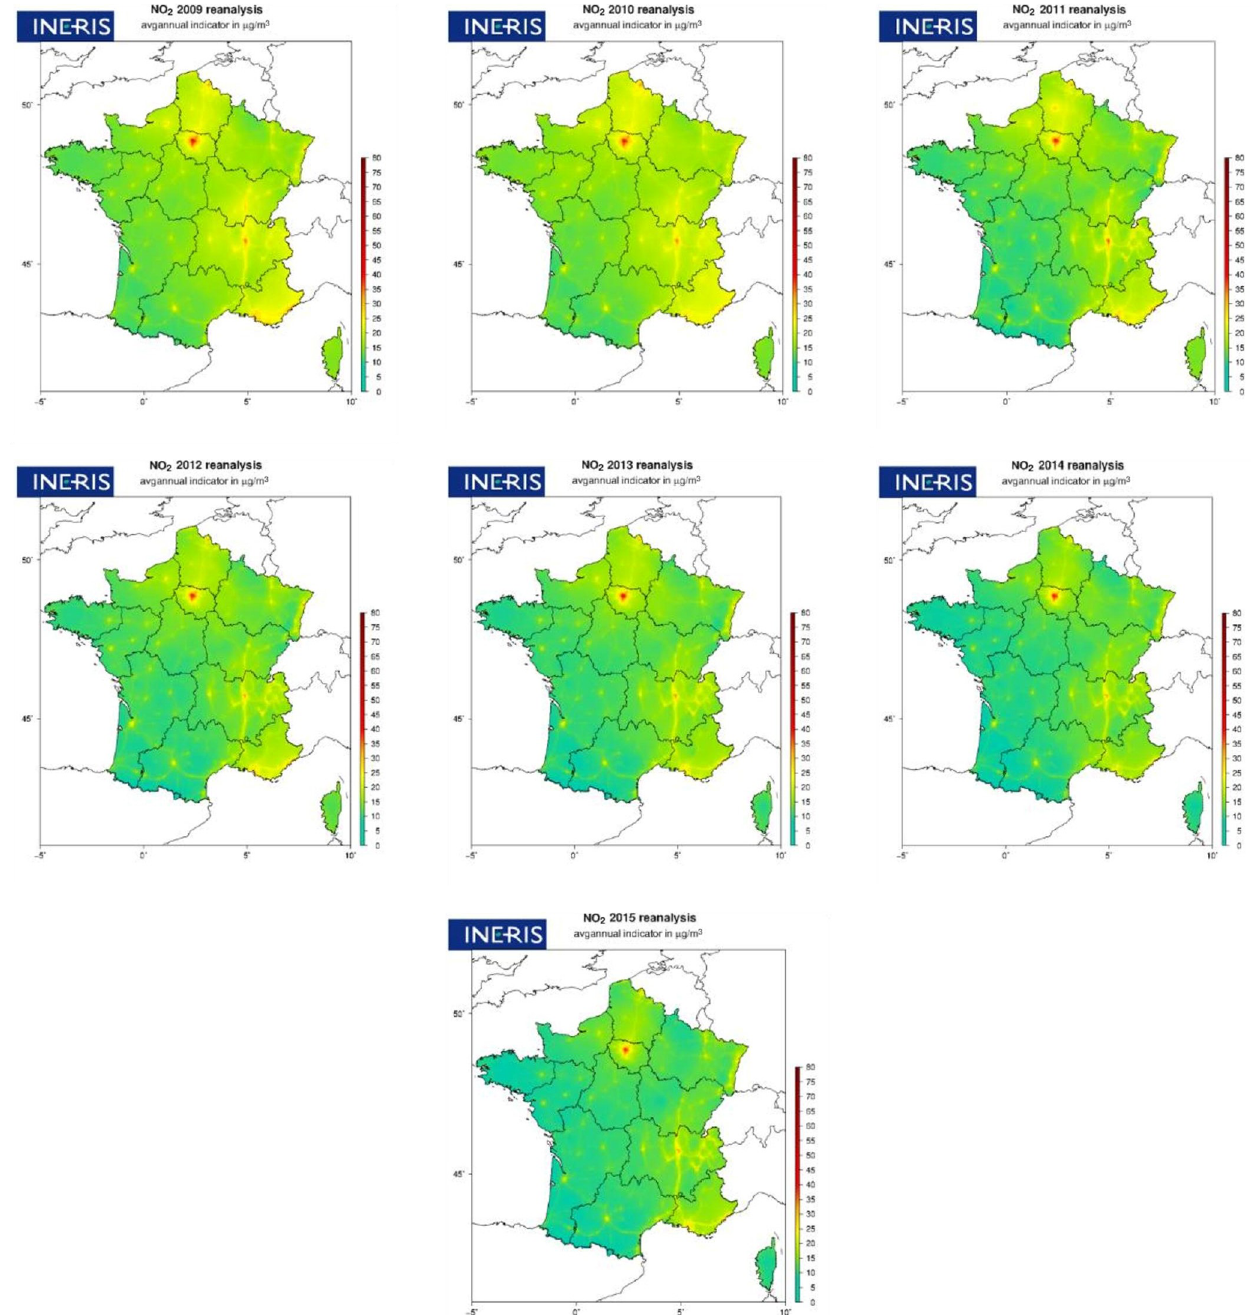
Figure 15. NO 2 annual mean concentrations for the period 2000 to 2015. NO 2 concentrations are obtained through a combination of regional modeling and